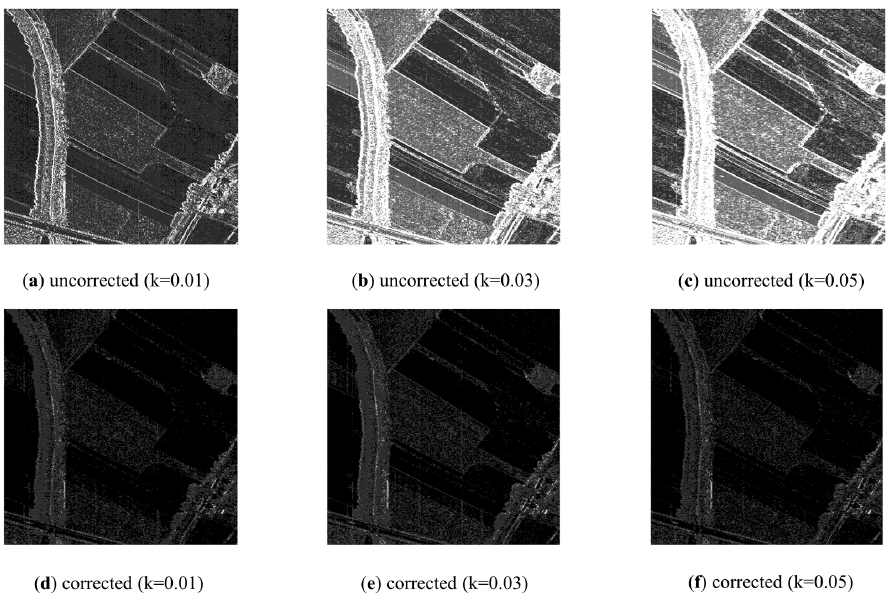
Figure 12. SAM between original image and the ( a ) uncorrected image with k of 0.01; ( b ) uncorrected image with k of 0.03; ( c ) uncorrected image with k of 0.05; ( d ) corrected image with k of